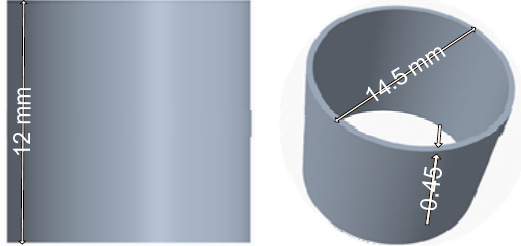
Figure 1. Product design (CAD model).